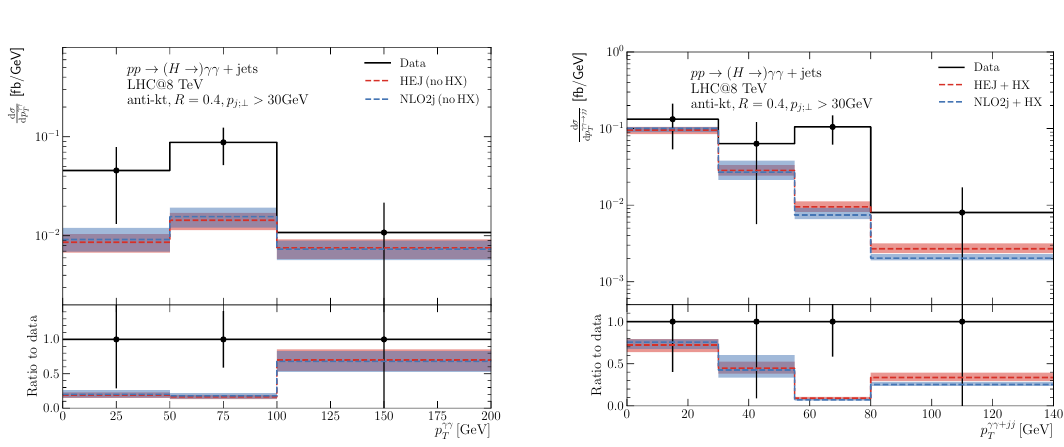
+ p j ) ⊥ . All 2 and 3-jet 1 2